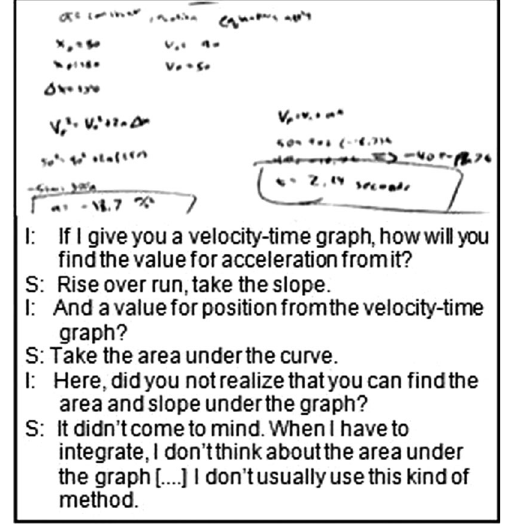
FIG. 6. Solvevalue from graphical representations (question 5).